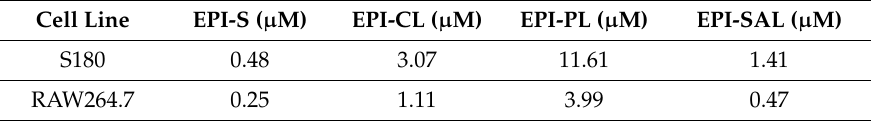
Table 3. IC 50 values of di ff erent EPI formulations in S180 and RAW264.7 cell lines. Cell